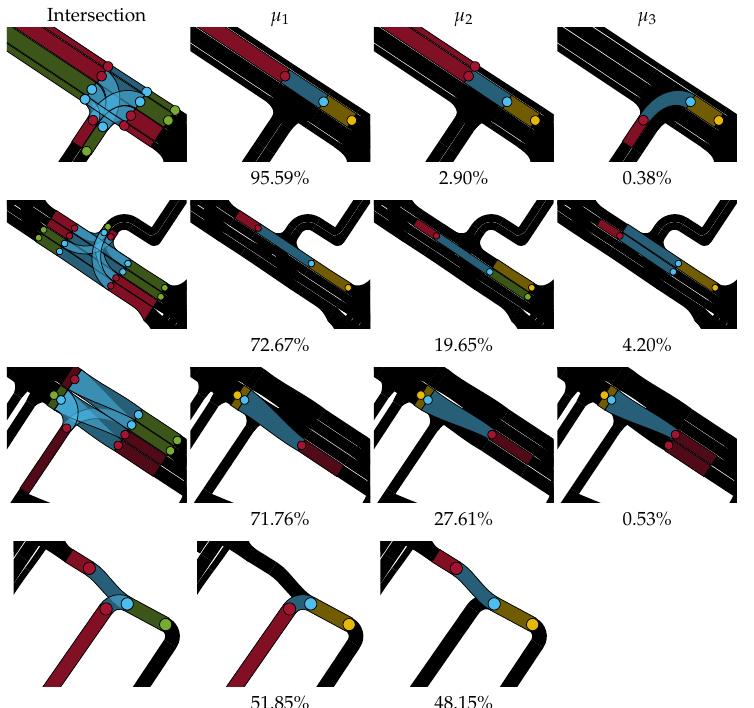
Figure 15. Shown is an example of the extraction of modes and estimation of the probability of each mode for four different types of intersections of the Lyft database. In the first column, the intersection is represented by the vertices that compose its graph. The second, third and fourth columns represent the most probable modes (from highest to lowest probability), given the observed subroute coloured in yellow and the history of the